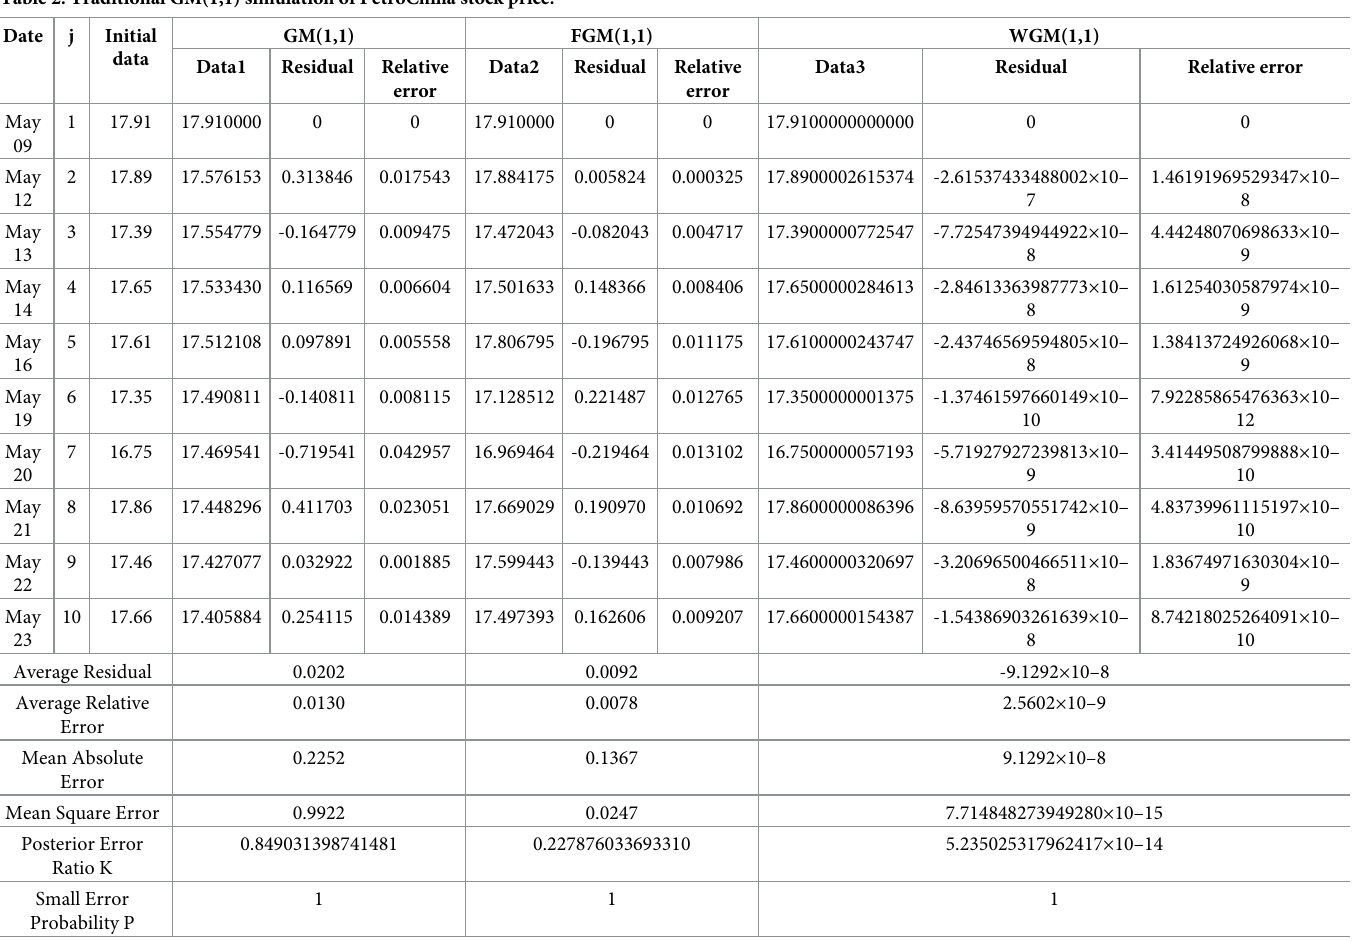
Table 2. Traditional GM(1,1) simulation of PetroChina stock